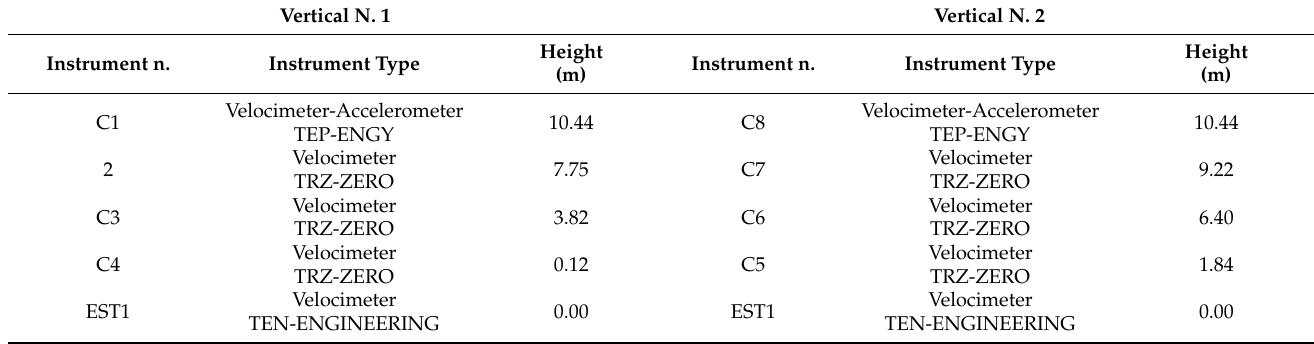
Table 4. Height at which the sensors were placed in the